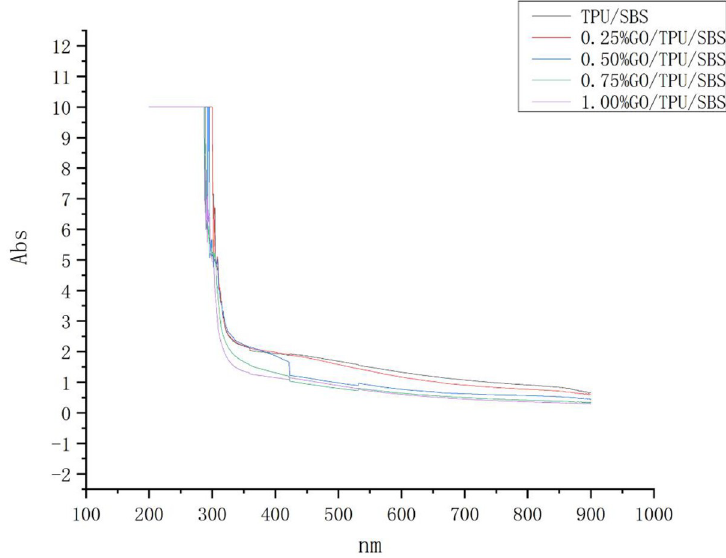
Fig 11. The UV-Vis spectra of the modified asphalt with different GO